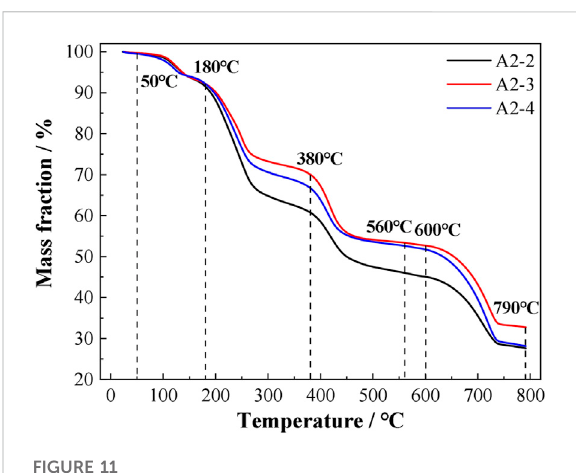
FIGURE 11 Thermogravimetric curve of repair